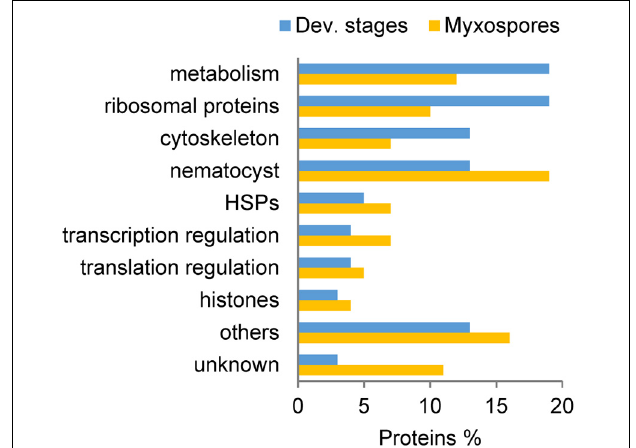
FIGURE 2 | Comparison of the 100 most abundant protein groups in developmental stages (Dev. stages) and mature myxospores. Proteins were grouped based on putative functions. HSPs: heat-shock proteins, unknown- with no annotation.